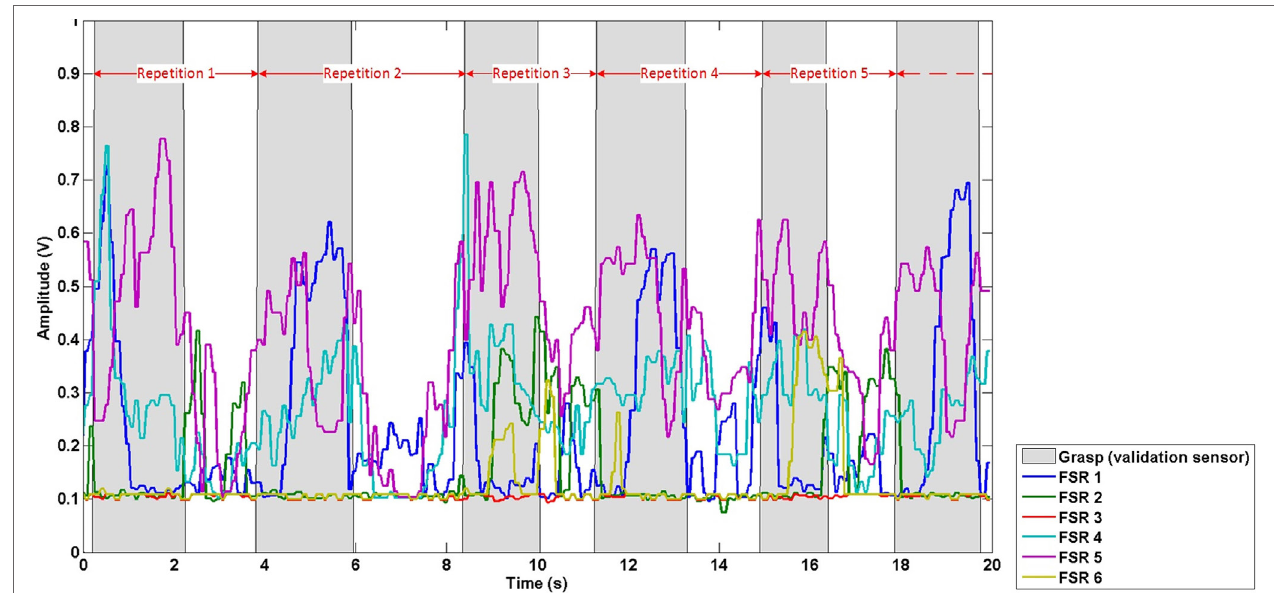
FigUre 3 | Exemplary repetition division scheme. Red arrows demark the division of data into repetitions based on the signal from the validation sensor (gray shading).